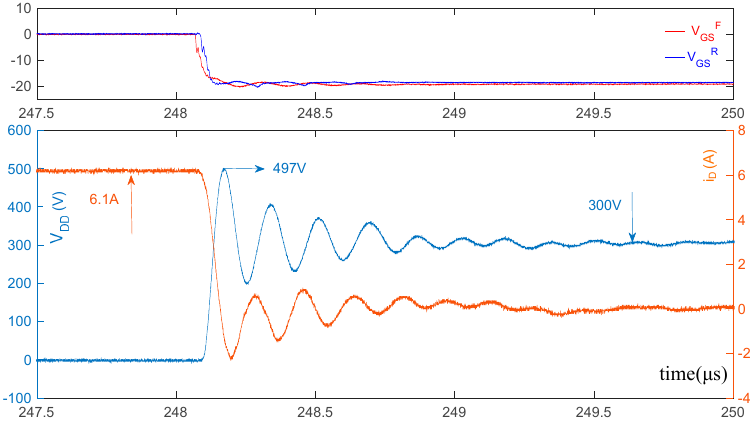
Figure 15. Turn-off transient under the condition of V in = 300 V, I L = 6.1 A, C X = 0.68 nF.